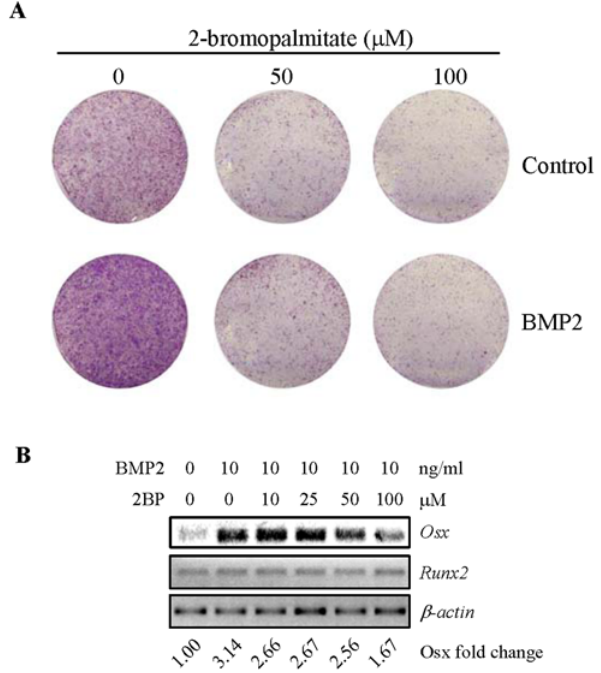
Figure 6. PAT inhibitor decreased BMP2-induced osteoblast differentiation, which was likely mediated by Osx. A. 2BP